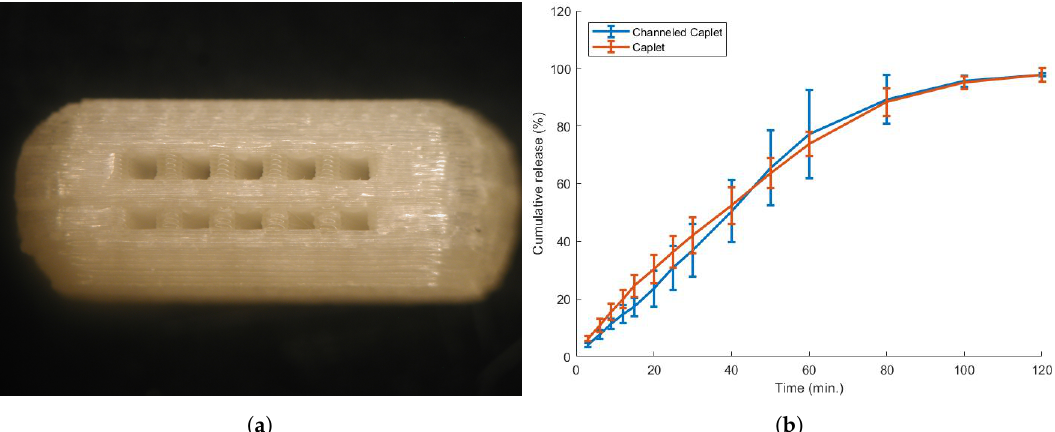
Figure 12. ( a ) The effect of caplet modification on the dissolution behaviour of the EPO:PEO:ZHT blend (69.3:29.7:1). Two rows with five columns of channels (0.6 mm size) were added to the caplet. ( b ) These modifications did not significantly alter the dissolution profile of the caplet.